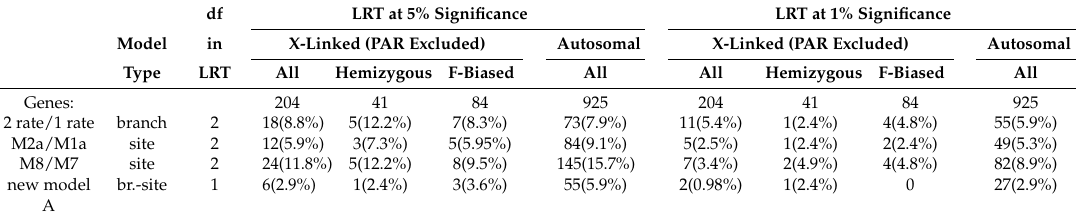
Table 1. Likelihood ratio tests (LRT) for adaptive evolution in six-species datasets. df